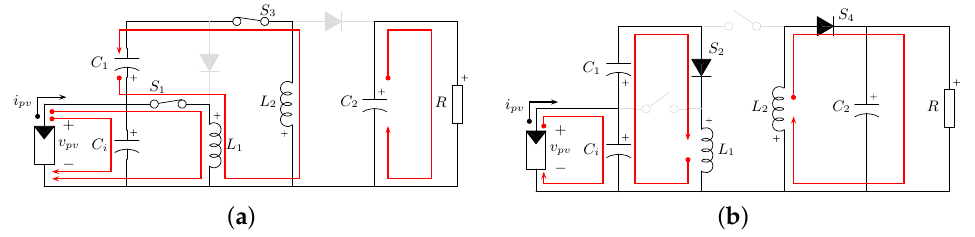
Figure 6. Operating modes of the proposed converter using a PV module. ( a ) Function q = 1. ( b ) Function q =